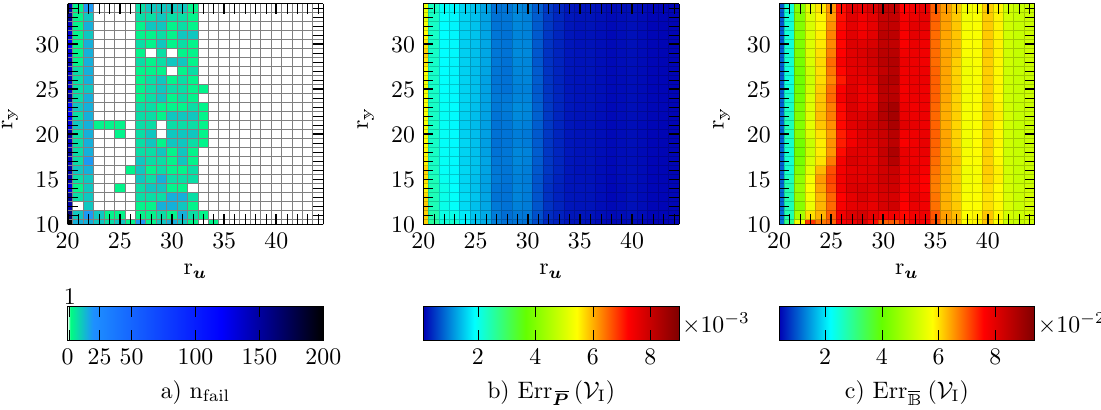
Figure 8. ( a ) robustness and ( b , c ) output error analysis for varying numbers of residuum modes r u and r y for sufficiently large numbers of gappy points p u = basis of size n u = 20 and n y =